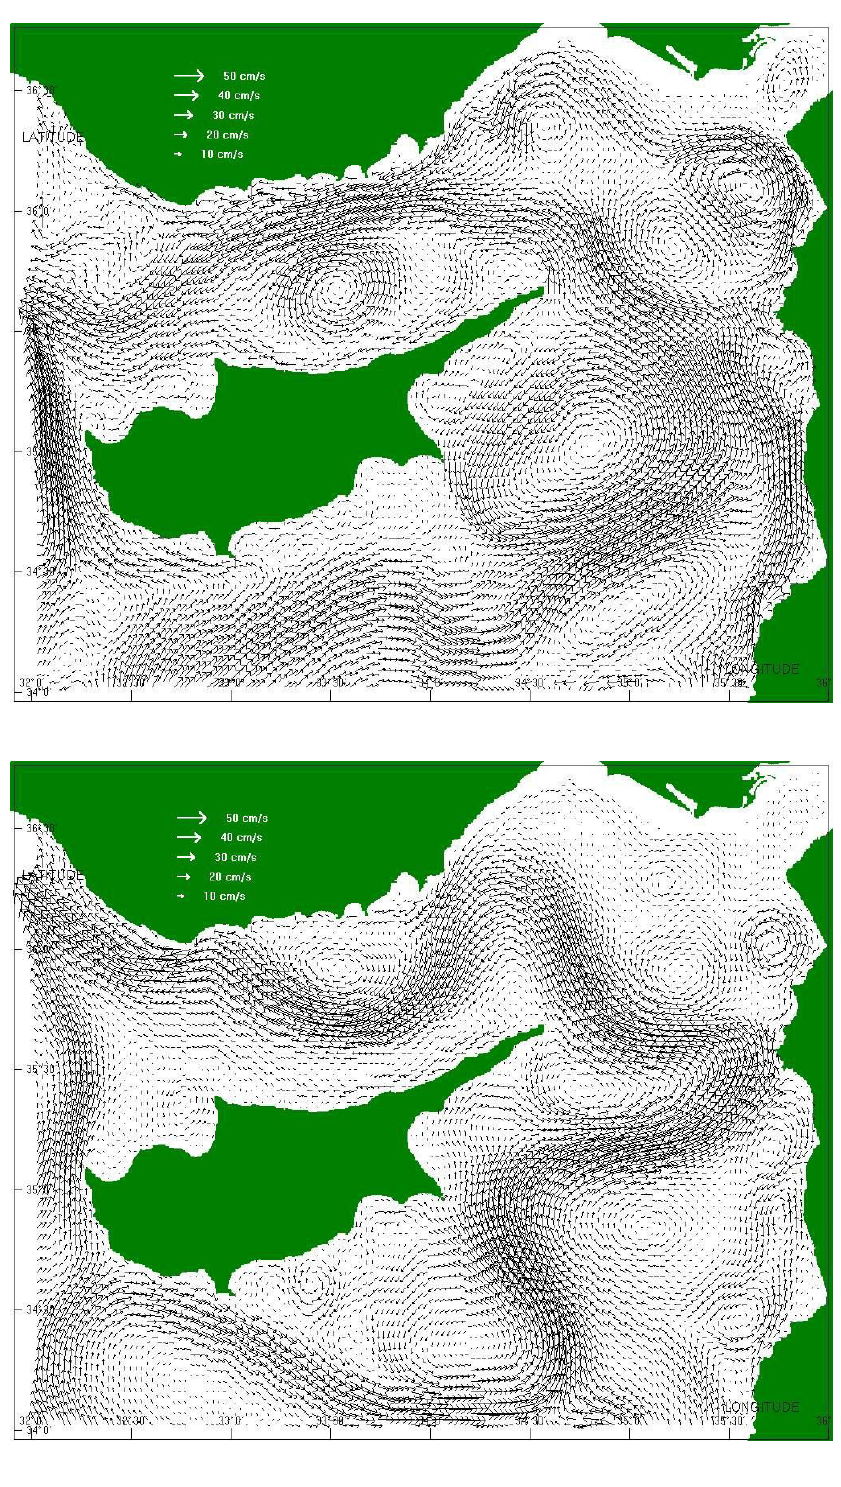
for August of the second year of the cli- matological